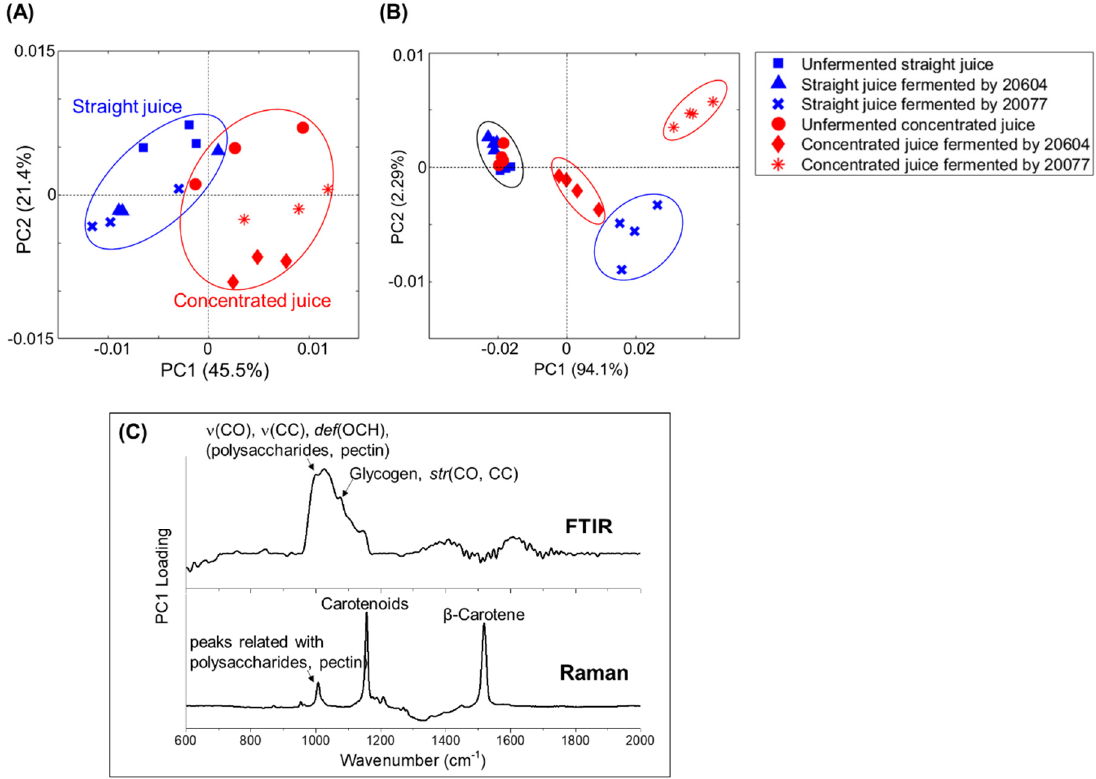
Figure 4. Scatter plots of first and second principal components (PC1 and PC2) from PCA of ( A ) FTIR spectra, ( B ) Raman spectra taken from unfermented carrot juices and fermented carrot juices by two L. gasseri strains and ( C ) loading values plot for PC1 from PCA.